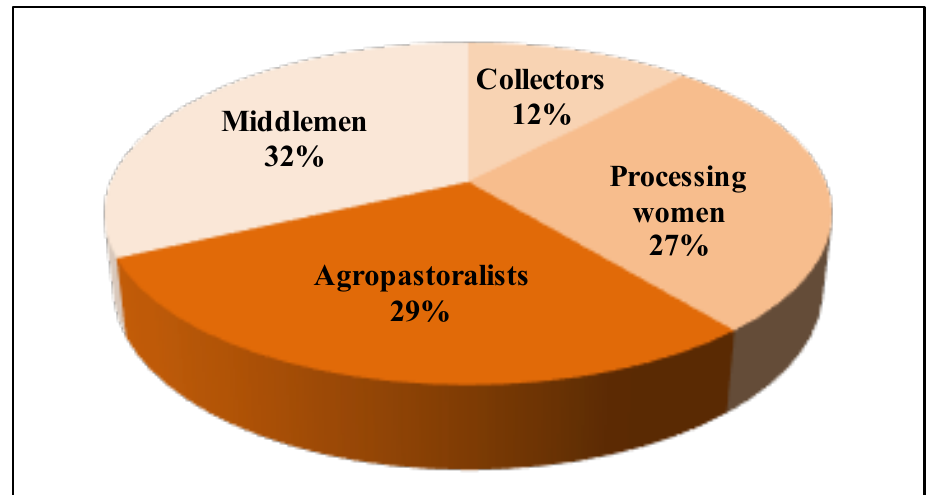
Figure 3. Contribution of each group of actors to the formation of the overall